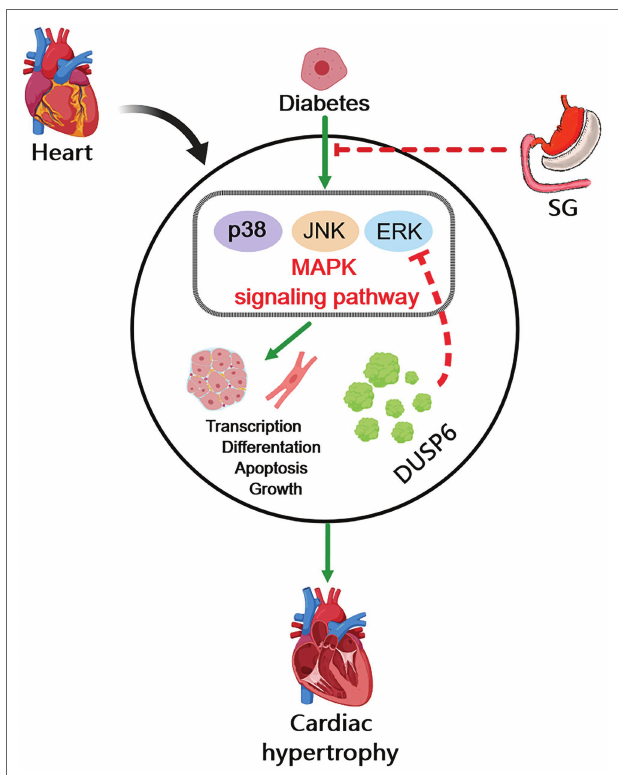
FIGURE 7 | Diagram of possible mechanism of SG improving diabetes- induced cardiac hypertrophy. In diabetes, overactivation of MAPK signaling pathway induces cardiac hypertrophy and heart dysfunction through promoting cell transcription, differentiation, apoptosis, and growth. The inhibition of MAPK signaling pathway is associated with the amelioration of diabetes-induced cardiac hypertrophy by SG. And the dephosphorylation of ERK1/2 by DUSP6 may play a vital role in this possible